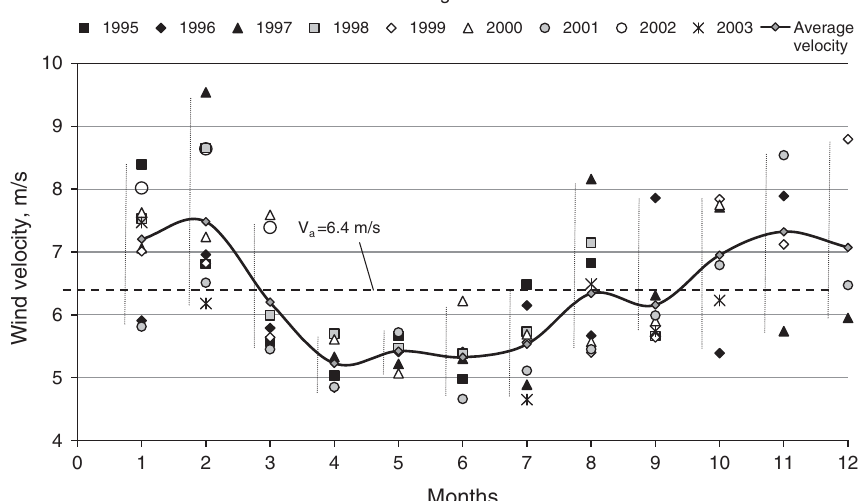
Fig. 3. Annual variation of average monthly wind velocity in the Baltic coastal region (Giruliai) at 50 meters height above ground level